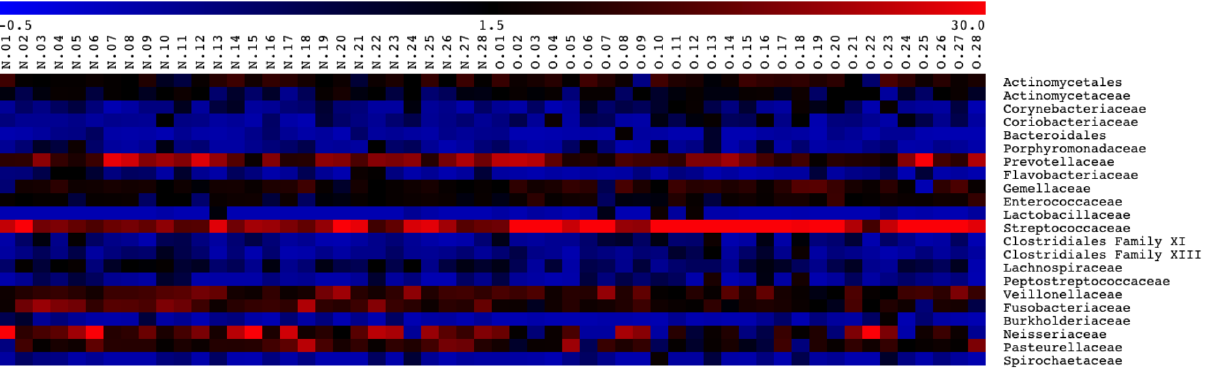
Figure 2. Abundance of bacterial families in salivary samples of N and O subjects. Microbial community structure and relative abundance of principal OTUs in saliva of normal-weight (N) and obese (O) subjects. Legend and scale shown in the upper part of the figure represent colors in the heat map associated with the relative percentage of each OTU within the samples.